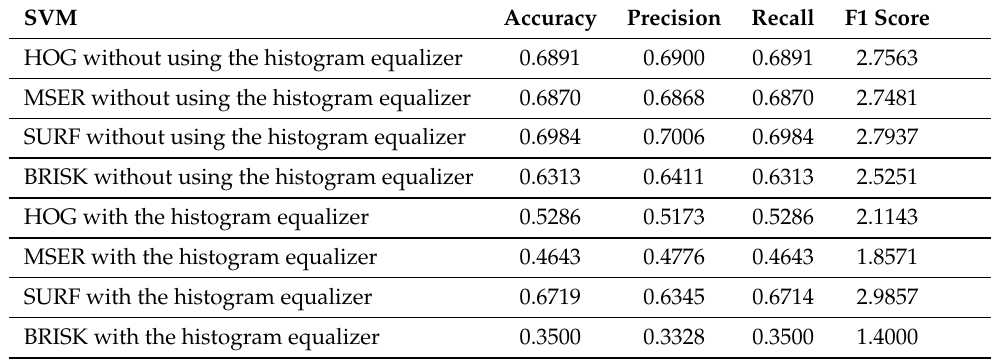
Table 2. Results of accuracy classification and algorithm evaluation for SVM.